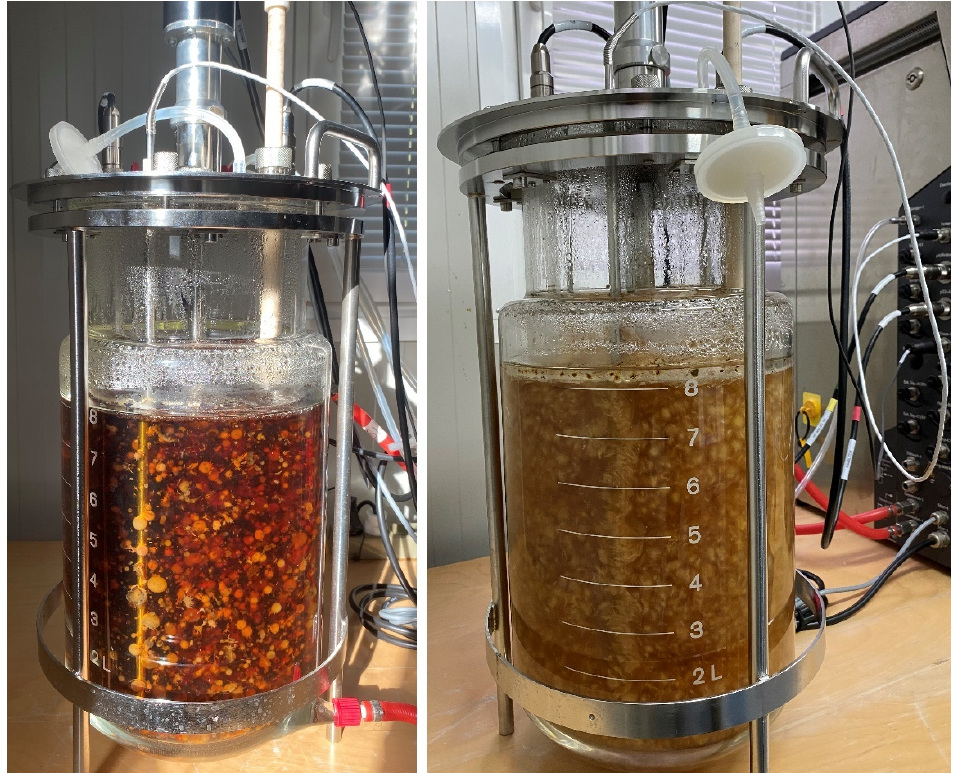
Figure 5. Different macroscopic growth patterns of the 15 day aged bioreactor cultures of I. obliquus mycelium grown in potato dextrose broth ( left ), showing extracellular pigment secretion and dispersed globular morphology, and optimized broth ( right ), unpigmented occupation of the entire bioreactor.